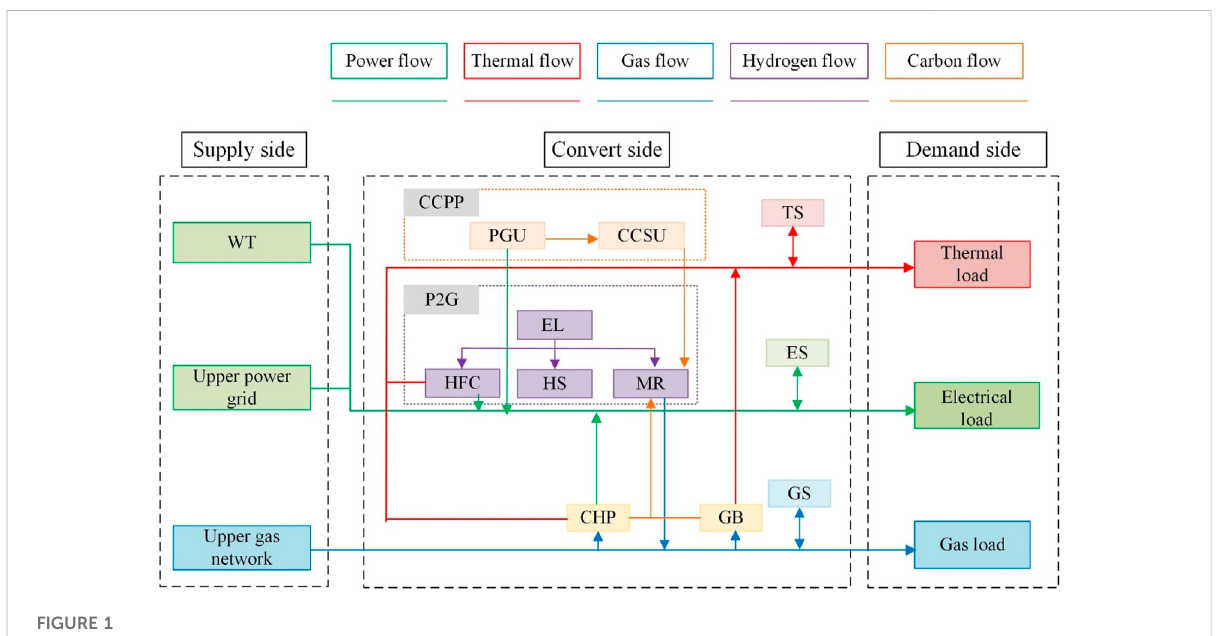
FIGURE 1 The IES dispatching